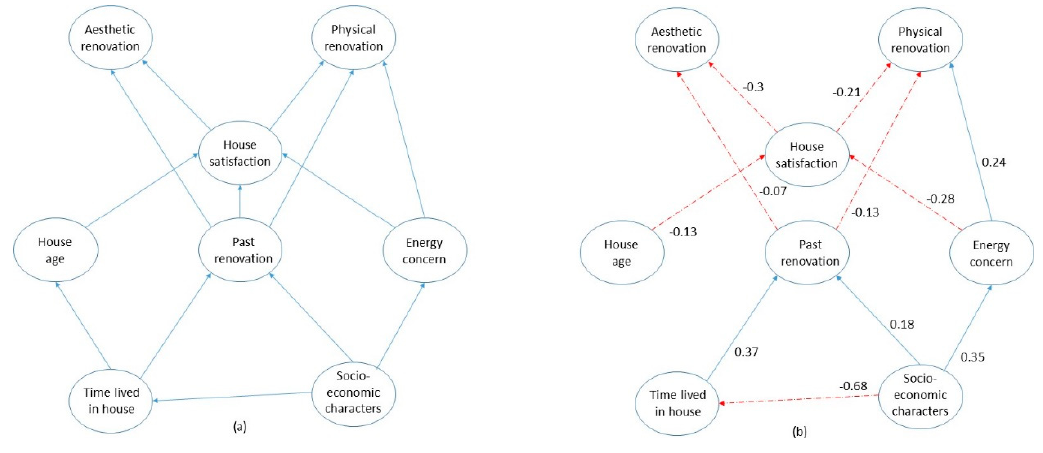
Figure 3. PLSPM analysis of physical and aesthetic renovation plans: ( a ) the model structure; and ( b ) the path coefficient estimates (paths with negative coefficients are dashed, and non-significant paths are omitted).